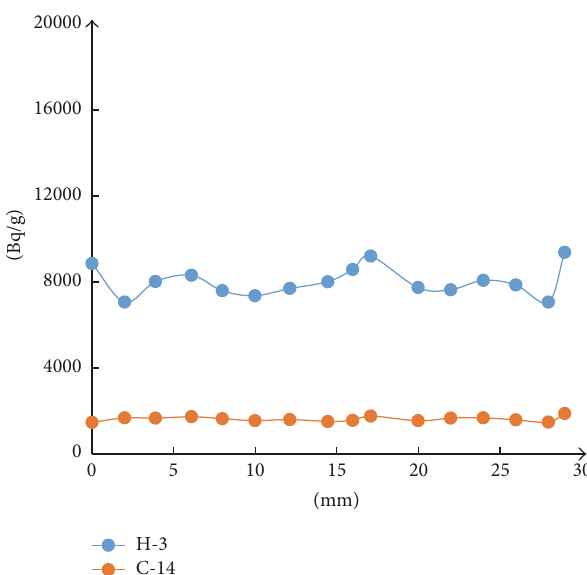
Figure 11: Profile of H-3 and C-14 specific activity at different spherical